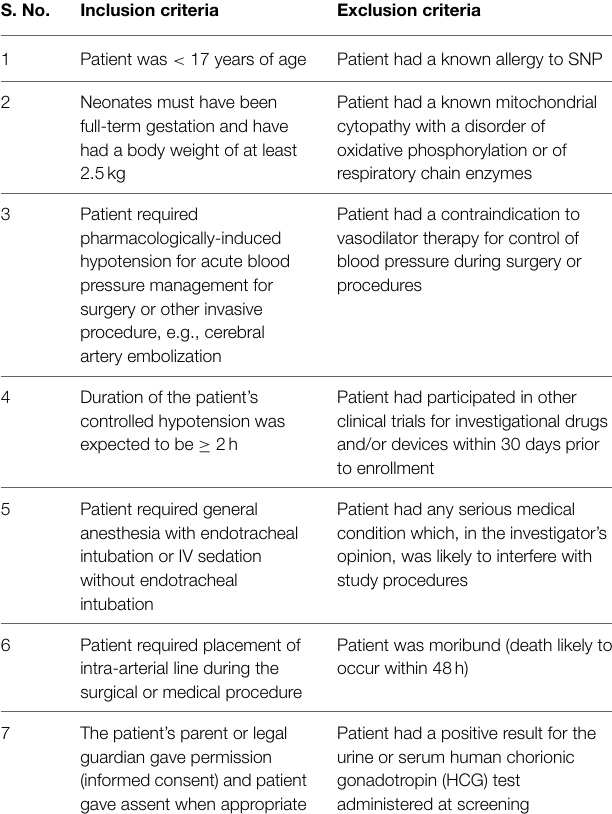
TABLE 1 | Inclusion and exclusion